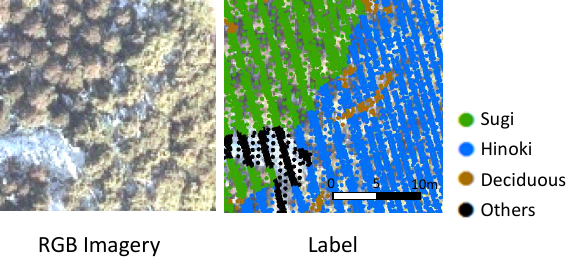
Figure. 5 Labels (ground truth)